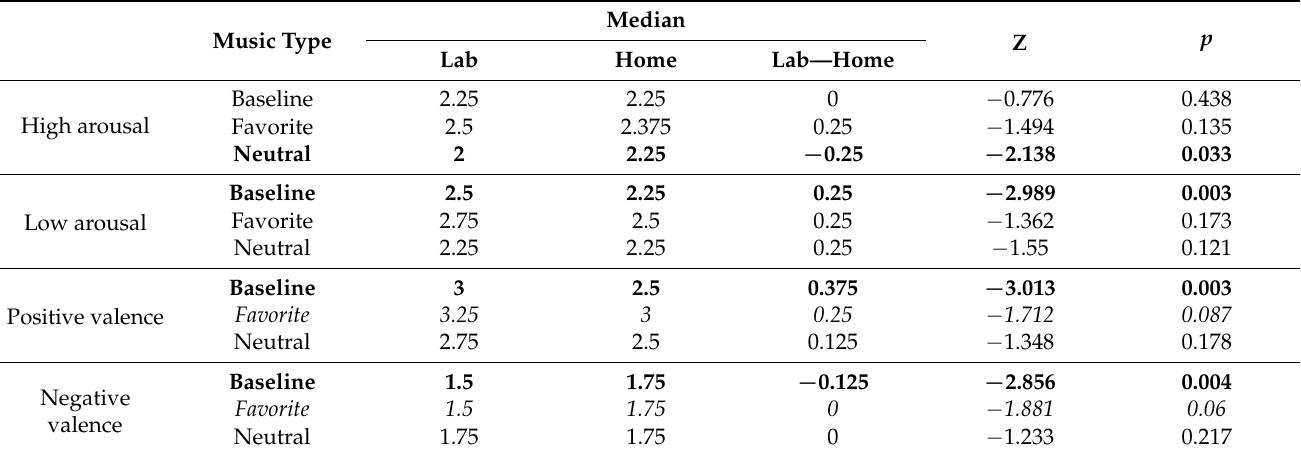
Table 1. Results of Wilcoxon signed-rank test comparing emotion ratings at home and in the laboratory. Significant results are marked with bold font and marginally significant with